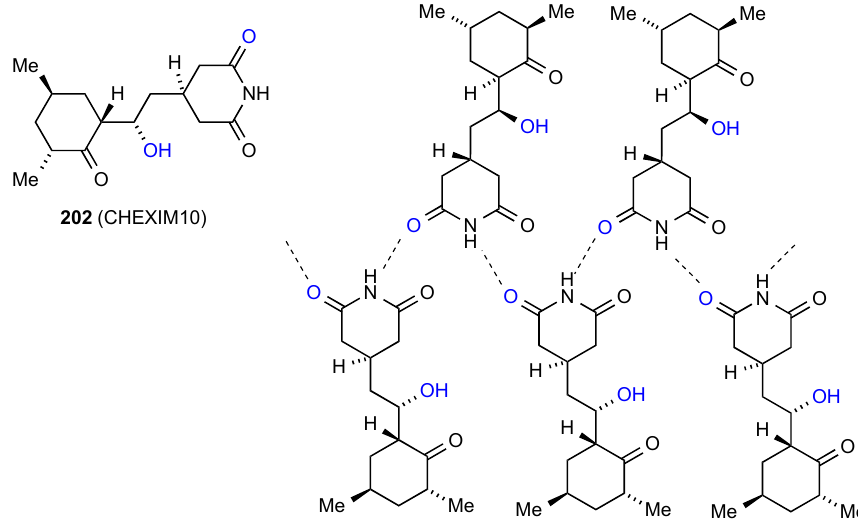
Figure 62. Structure adopted by compound 202.